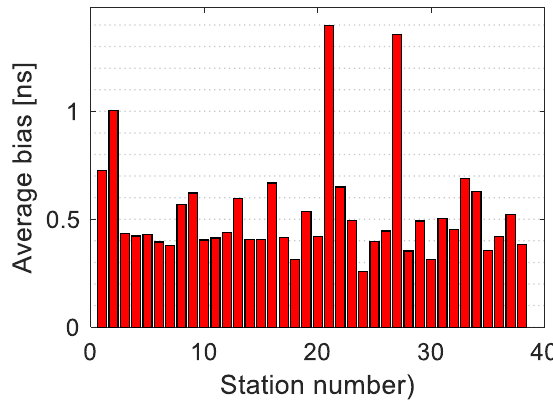
Figure 3. Averaged bias between IFCB1 and IFCB2 for each station in DOY 277 – 297.